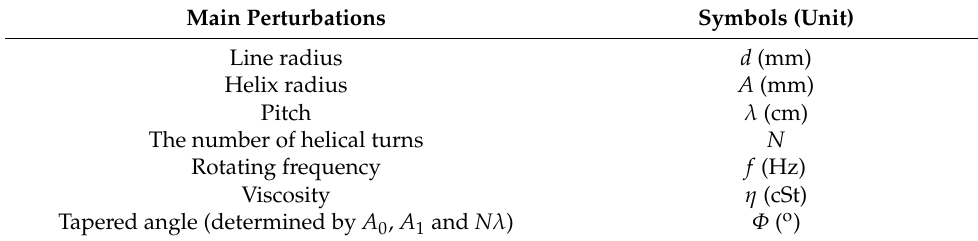
Table 6. The main perturbations in the evaluation system of this